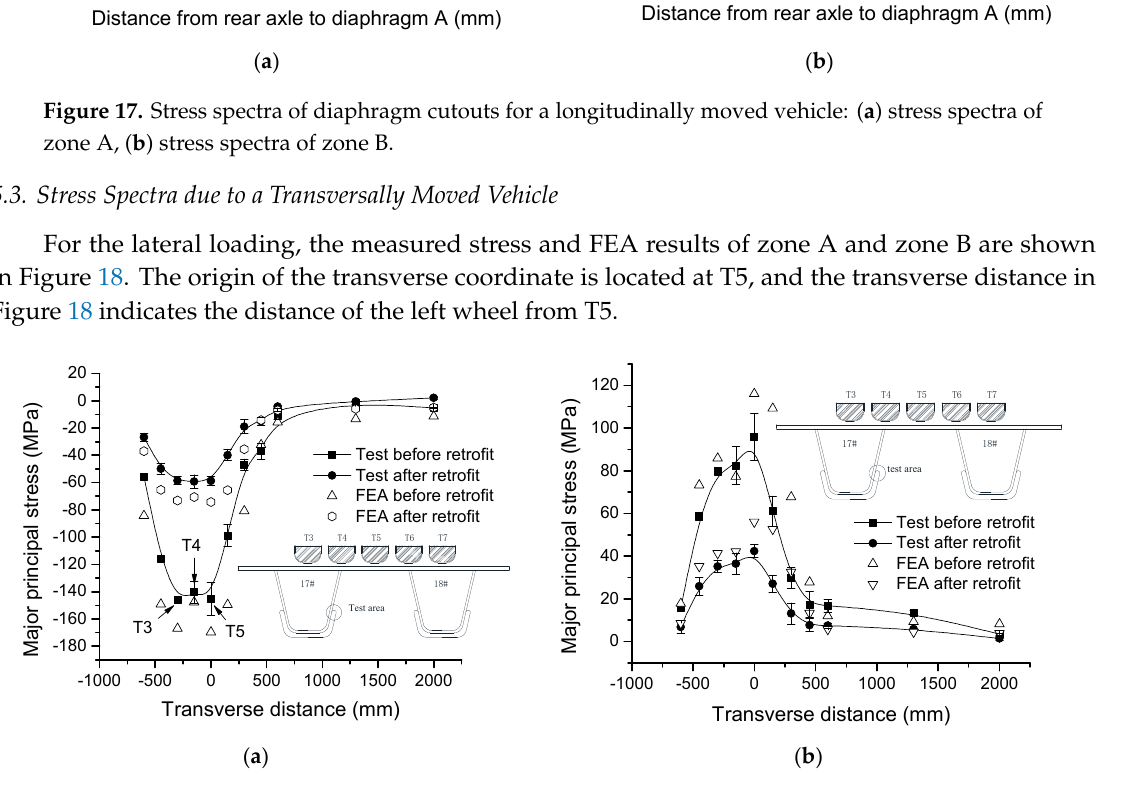
Figure 18. Stress spectra of diaphragm cutouts under lateral moved vehicle: ( a ) stress spectra of zone A, ( b ) stress spectra of zone B.